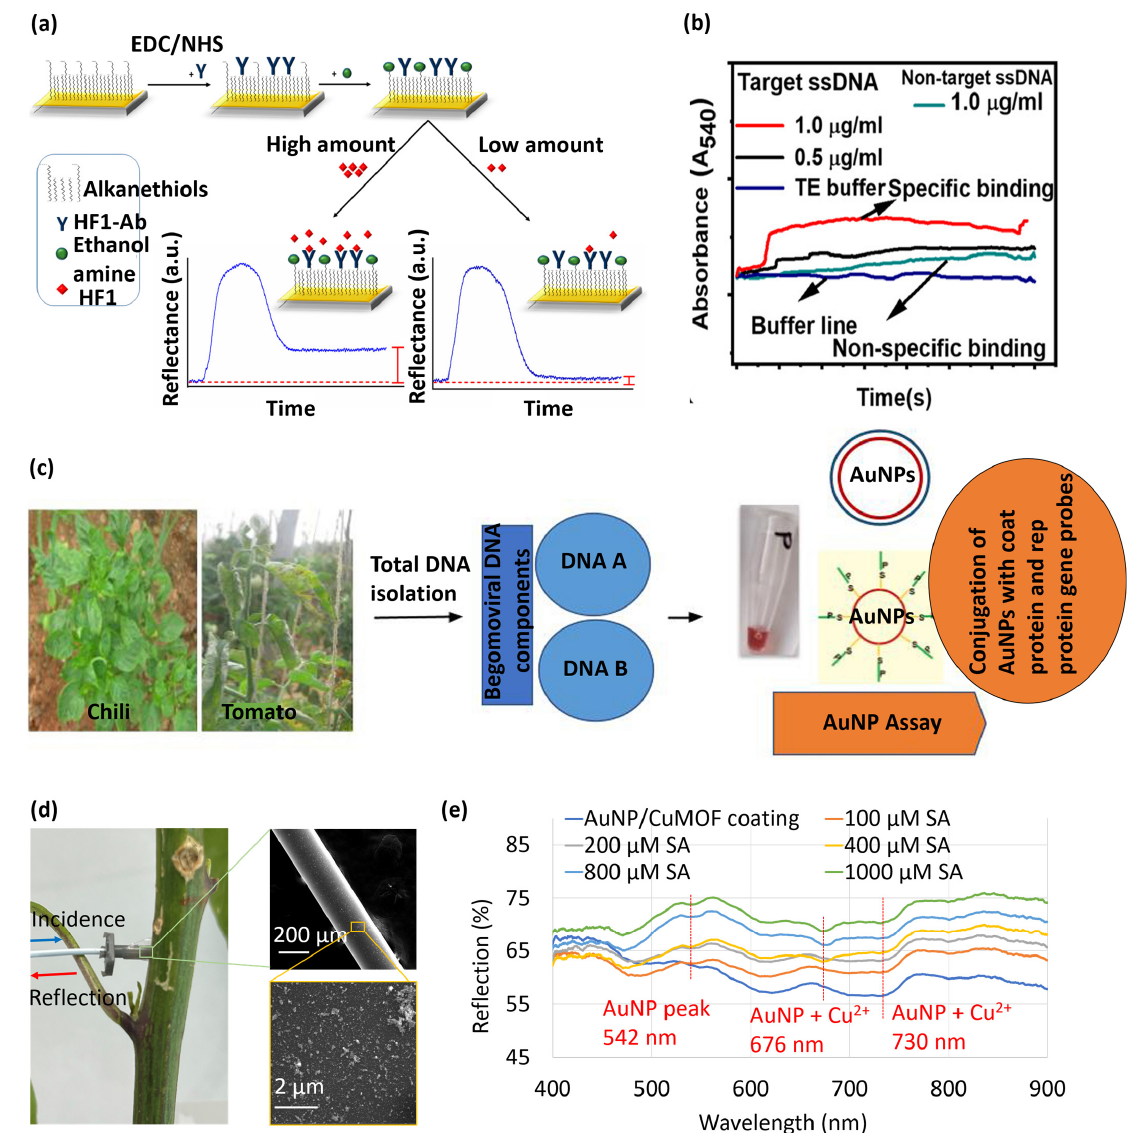
Figure 3. ( a ) Sensograms demonstrating the detection of HF1 by the LSPR immunoassay [158]. Here, EDC = 1‑ethyl‑3‑(3‑dimethylaminopropyl) carbodiimide and NHS = N‑hydroxysuccinimide. Copyright © MDPI, Luna‑Moreno et al. ( b ) Dynamic variation in absorbance due to specific (viral ssDNA) and non‑specific (healthy ssDNA) binding to the LSPR probes [165]. Copyright © ACS, Das et al. ( c ) Process flow for detecting Begomovirus in chili and tomato plants using functionalized gold nanoparticles [166] copyright © Springer Nature, Lavanya et al. (http://creativecommons.org/licenses/by/4.0/, accessed on 29 December 2022) ( d , e ) in situ SA measurements in the stem of a live plant and resulting reflection spectra for SA sensing in plant sap [20] Copyright © SPIE, Tabassum.